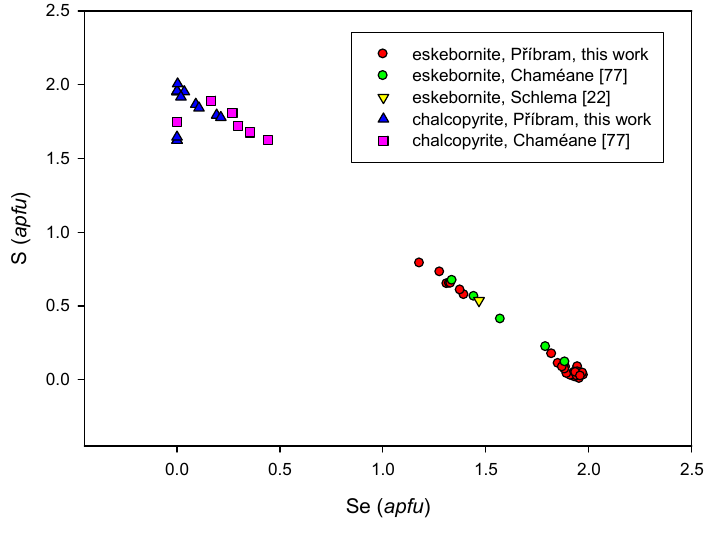
Figure 34. Se vs. S ( apfu ) graph of chalcopyrite and eskebornite from various localities.